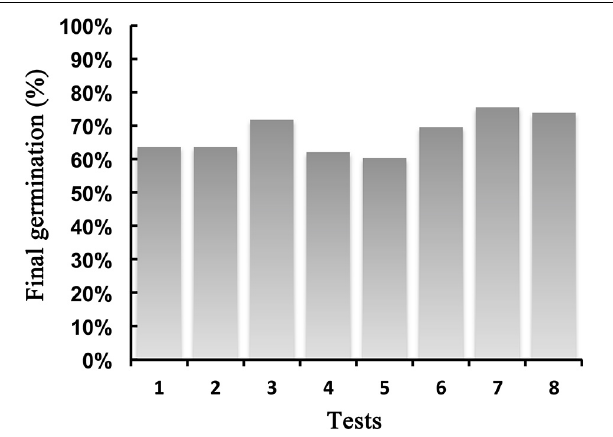
FIGURE 4 | Best germination percentages achieved in different germination tests (substrate/luminosity/environment/other treatments). (1) Sterile soil, light, and room temperature. (2) Natural soil, light, and room temperature. (3) Cotton fibers, with soil suspension, light, room temperature, and seeds bleached. (4) Cotton fibers, in water; light; room temperature; and seeds bleached. (5) Agar, darkness, and controlled light and temperature. (6) Agar, light, and controlled light and temperature. (7) Agar, light, controlled light and temperature, and Al. (8) Agar, light, controlled light and temperature, and Al + Ca. Data from Serrano, 2015, Chapter 7